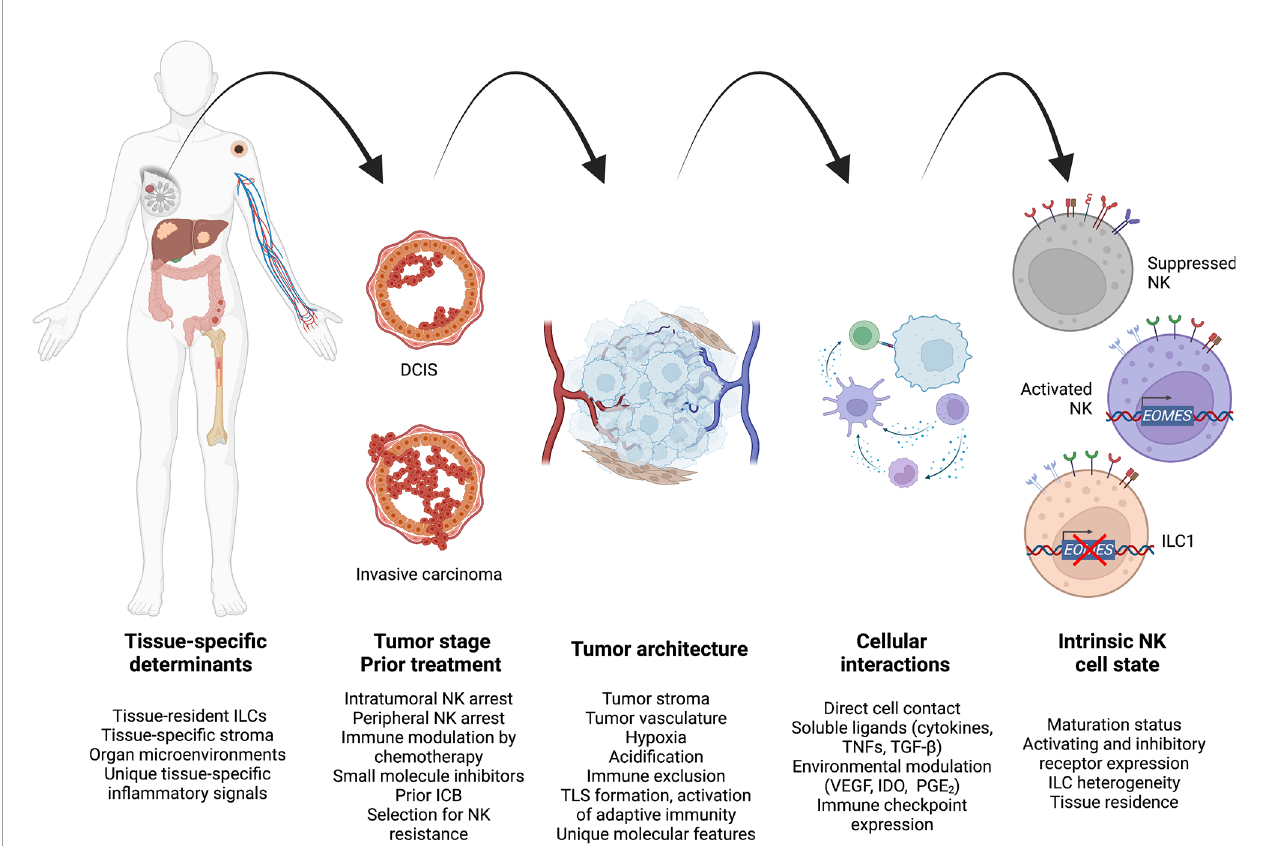
FIGURE 3 | A uni fi ed model to integrate high-level spatiotemporal and intracellular factors governing antitumor NK cell regulation during cancer progression. Created using